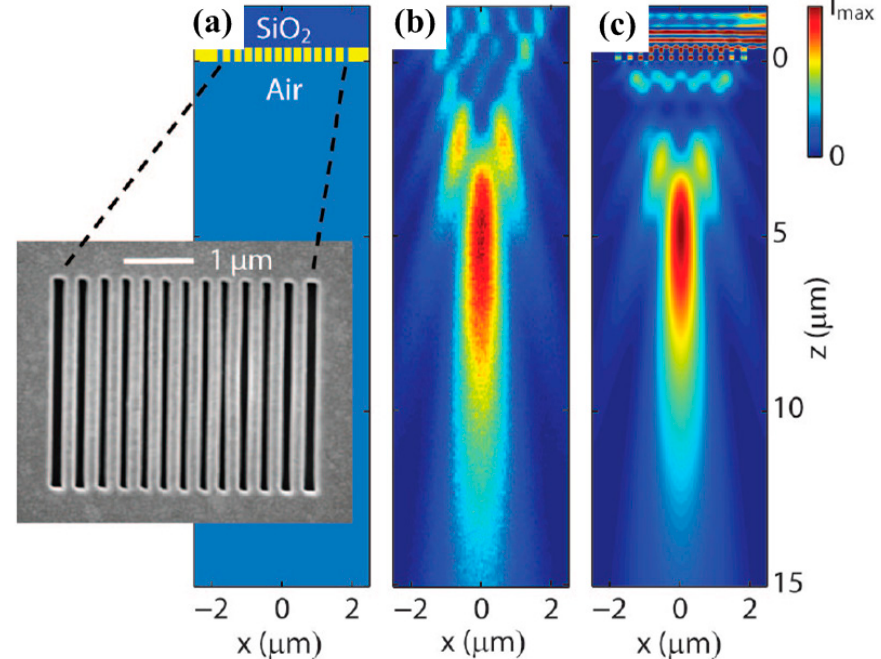
Figure 4. ( a ) Schematic and SEM image of the nanoslit array plasmonic lens. ( b ) Experimental results of transmitted intensity distribution captured by a confocal microscope. ( c ) FDTD-calculated result showing the intensity distribution which agrees well with measurements. Reproduced with permission from [103]. Copyright American Chemical Society, 2009.